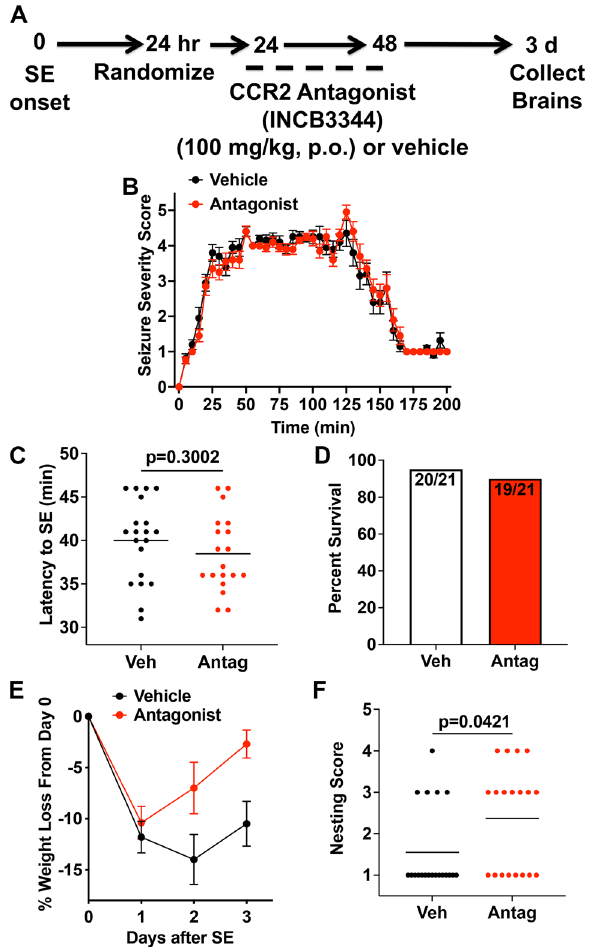
Figure 2. Post-SE treatment with CCR2 antagonist facilitates functional recovery after SE. ( A ) Experimental procedure for post-SE treatment with the CCR2 antagonist. Mice were injected with kainic acid (KA) (30 mg/kg, i.p.) to induce seizures. Twenty-four hours after SE onset the mice were randomized into vehicle (5% NMP, 5% Solutol HS-15, 30% PEG-400, and 60% citric acid (10 mM)) or CCR2 antagonist INCB3344 (100 mg/kg, p.o.). Mice were administered the CCR2 antagonist 24- and 48-h post-SE onset and sacrificed 72 h after SE onset. The mice were checked daily for body weight and mortality. ( B ) The behavioral seizure score was tabulated every 5 min. The temporal evolution of SE was similar in both treatment groups. ( C ) The latency to SE after KA injection, as judged by the behavioral SE score, was similar in vehicle- and CCR2 antagonist-treated mice (the horizontal line is at the mean, symbols represent individual mice; veh n = 20, antag n = 19, unpaired t-test, p = 0.300. ( D ) Three-day survival rates of mice that received vehicle or CCR2 antagonist. ( E ) CCR2 antagonist- treated mice (red circles) regained lost body weight faster than vehicle-treated mice (black circles) (veh n = 20, antag n = 19; two-way ANOVA, the effect of treatment, F(1,111) = 10.83, p = 0.0013). Data points indicate mean ± SEM. ( F ) Nesting behavior three days after SE (the horizontal line is the mean, symbols represent individual mice; veh n = 20, antag n = 19, Mann–Whitney test, p = 0.0421). The achieved power to have detected a real difference was